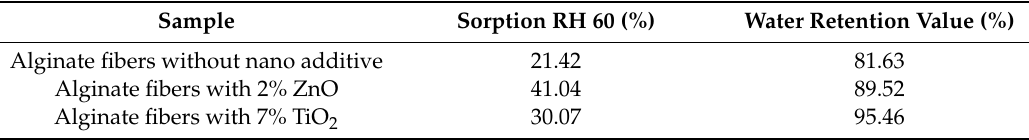
Table 4. Fiber sorption and retention